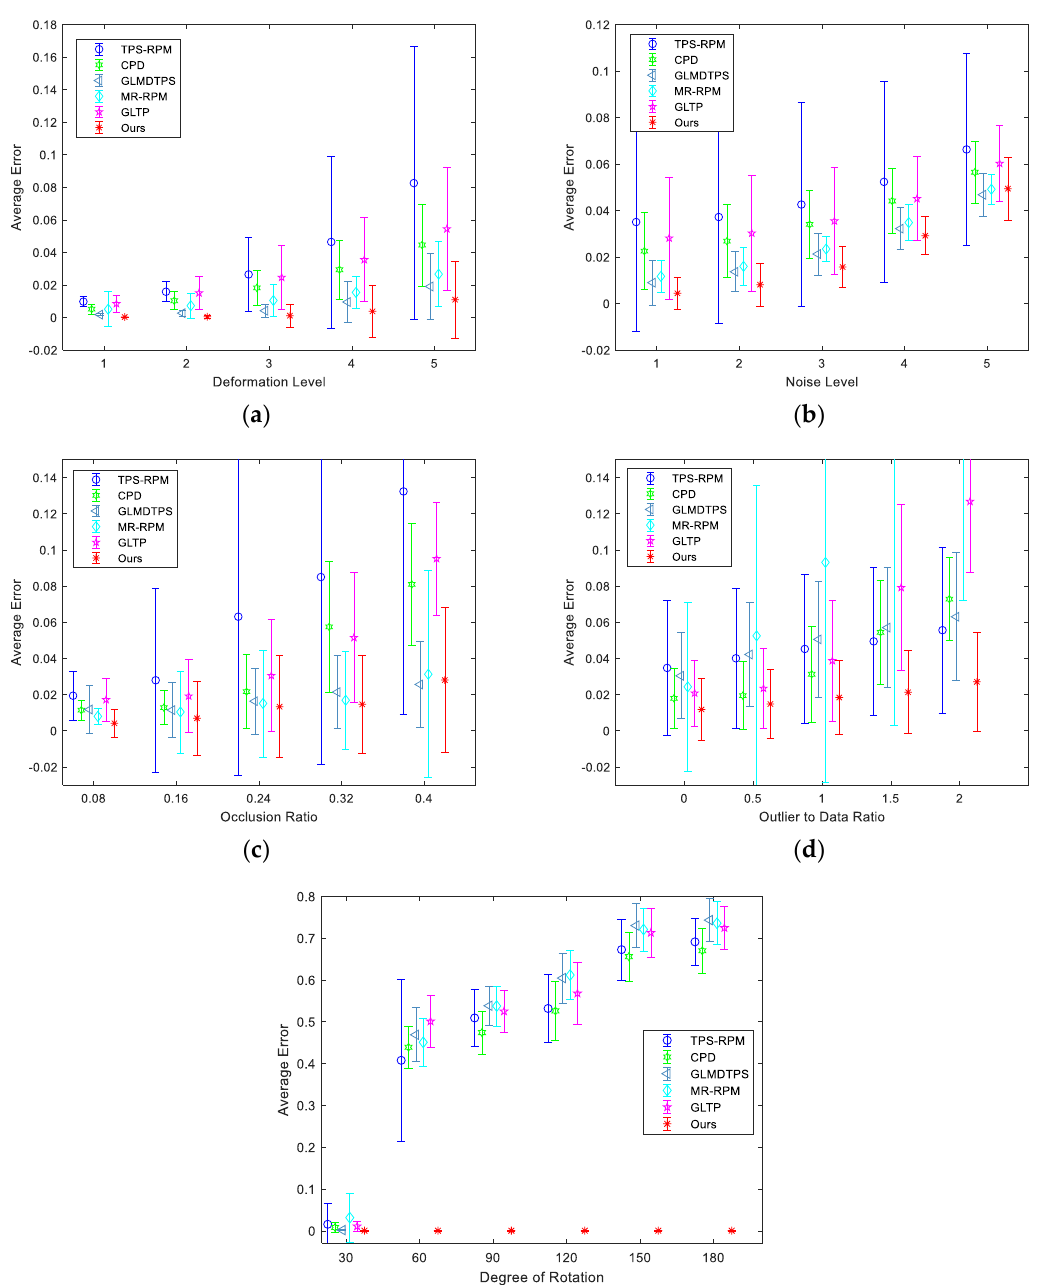
shows the registration results. From left to right: deformation, noise, occlusion, outliers, and rotation. The model points and the scene points are marked by “ + ” and “ o, ” respectively.